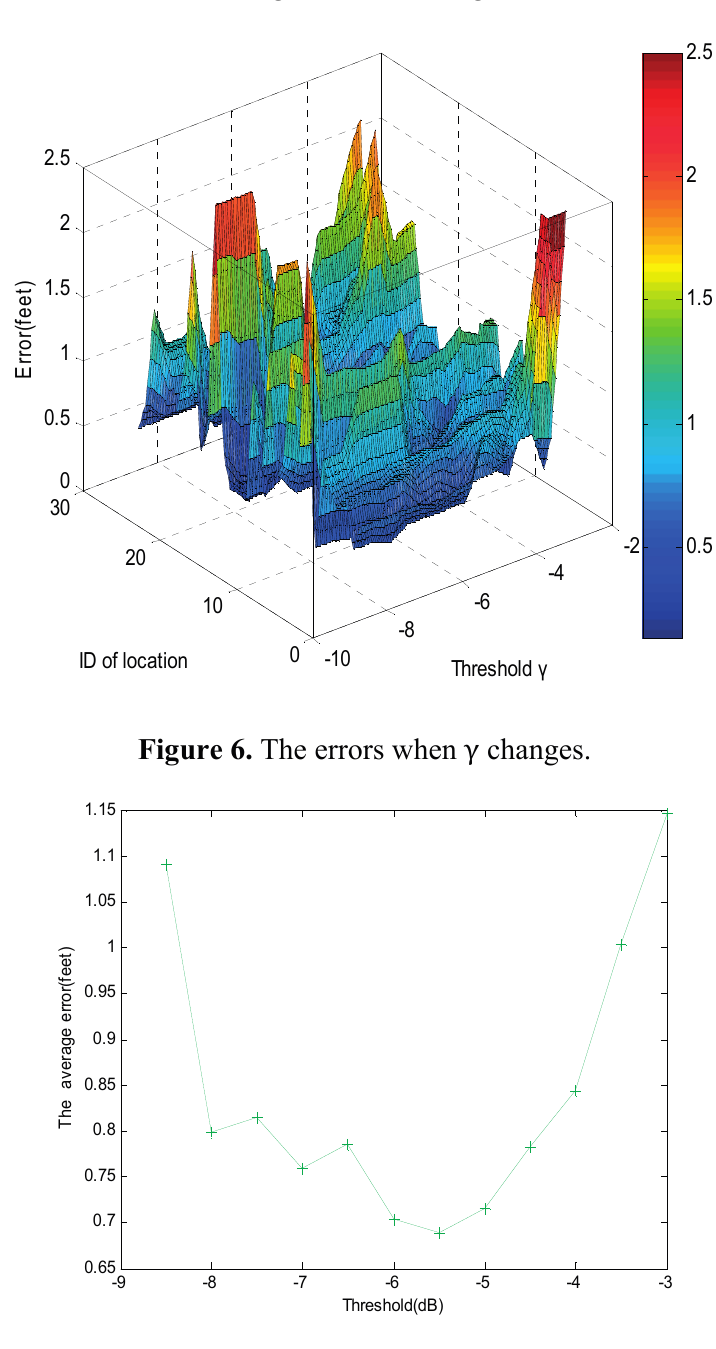
Figure 7. Average errors for different γ